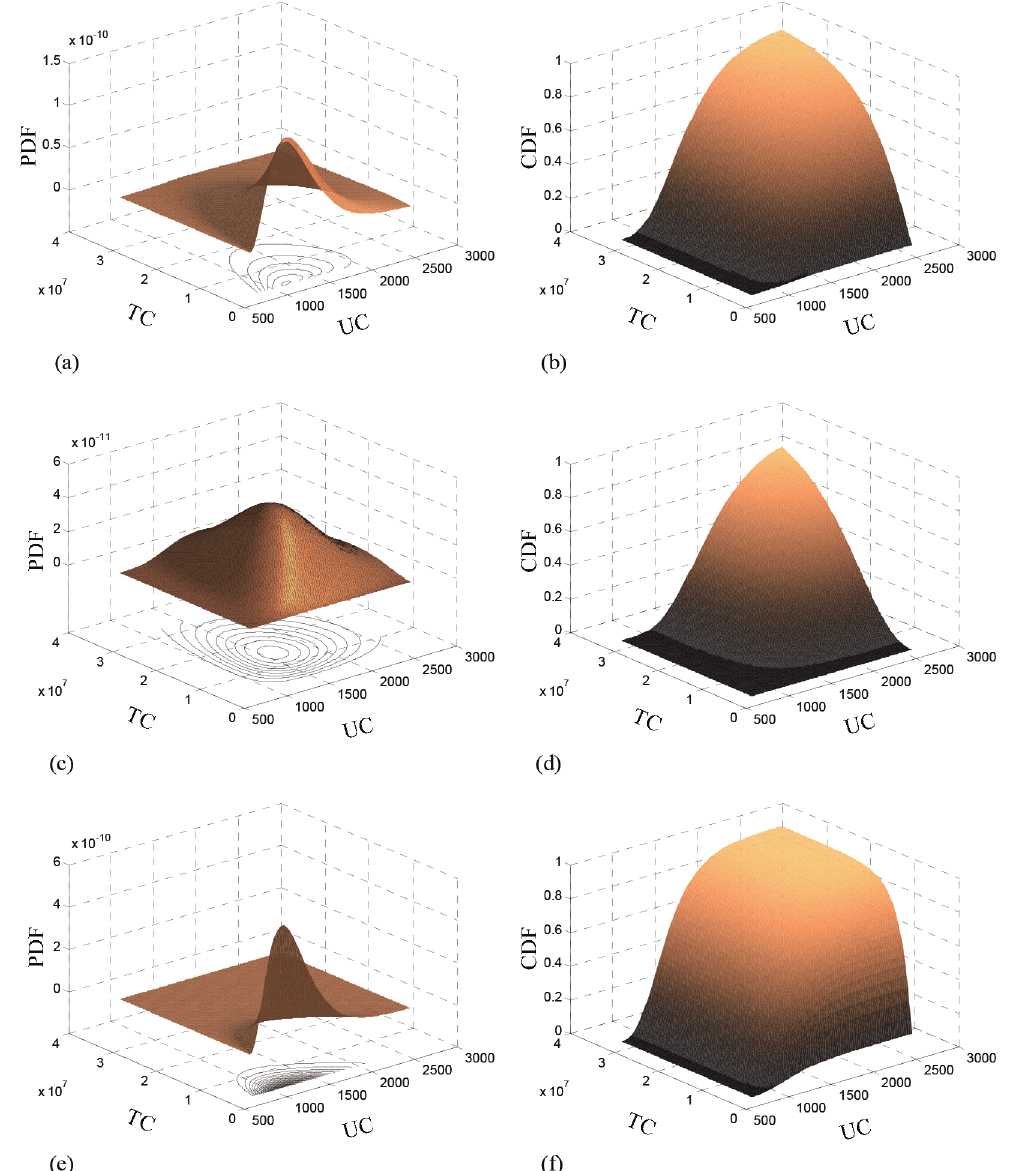
Figure 7. The unconditional and conditional joint distribution of TC and UC : (a) unconditional PDF; (b) unconditional CDF; (c) conditional PDF given the 5 th percentile of D ; (d) conditional CDF given the 5 th percentile of D ; (e) conditional PDF given the 95 th percentile of D ; (f) conditional CDF given the 95 th percentile of